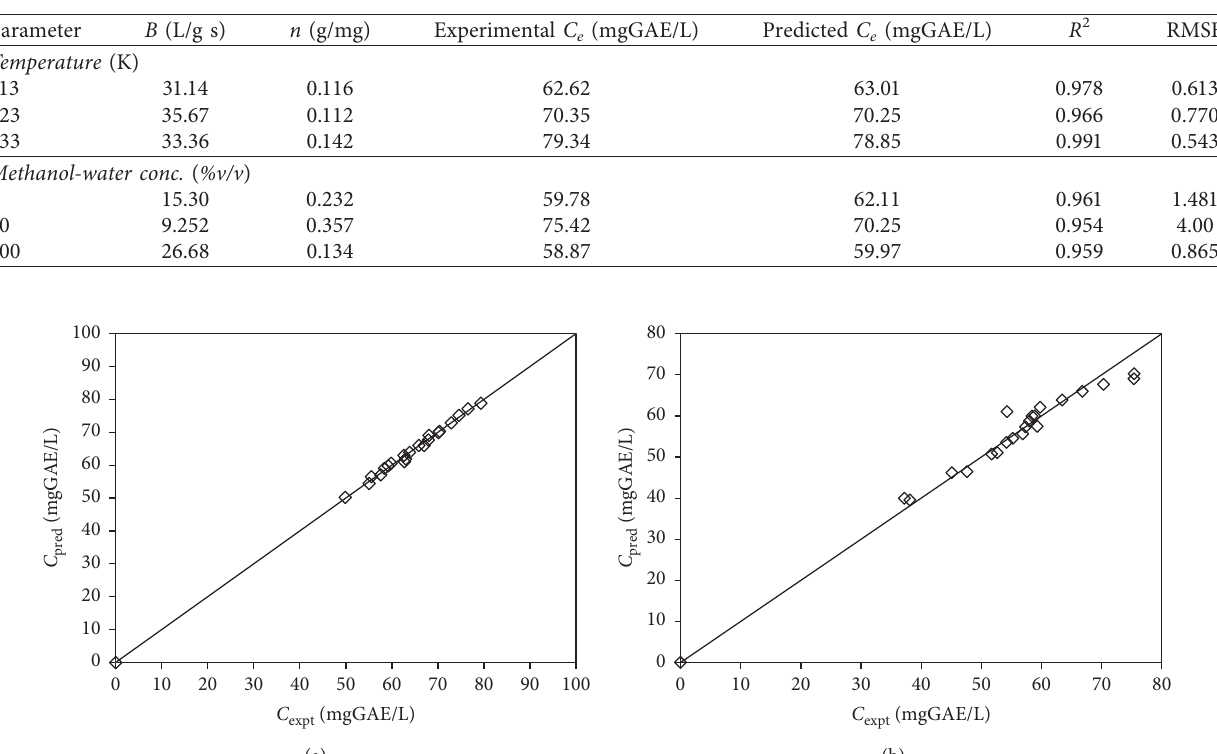
Table 2: Kinetic parameters for Power law model and experimental and predicted equilibrium concentration values at different extraction